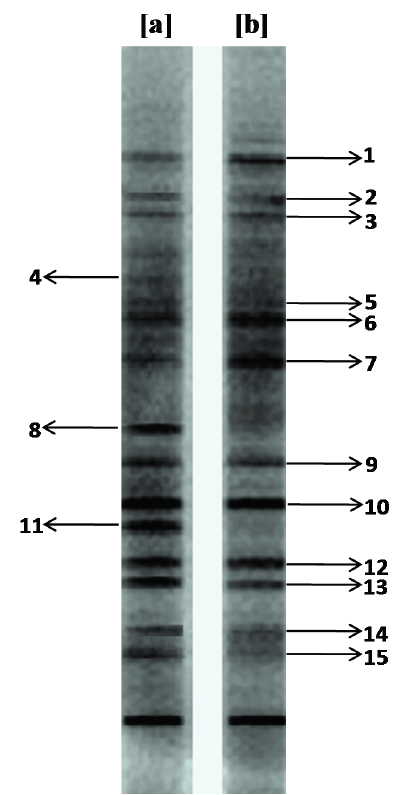
Figure 2. DGGE pattern of the PCR amplified 16S rDNA genes of enriched microbial consortium ( a ) before and ( b ) after decolorization of dye Trypan Blue (50 mg·L − 1